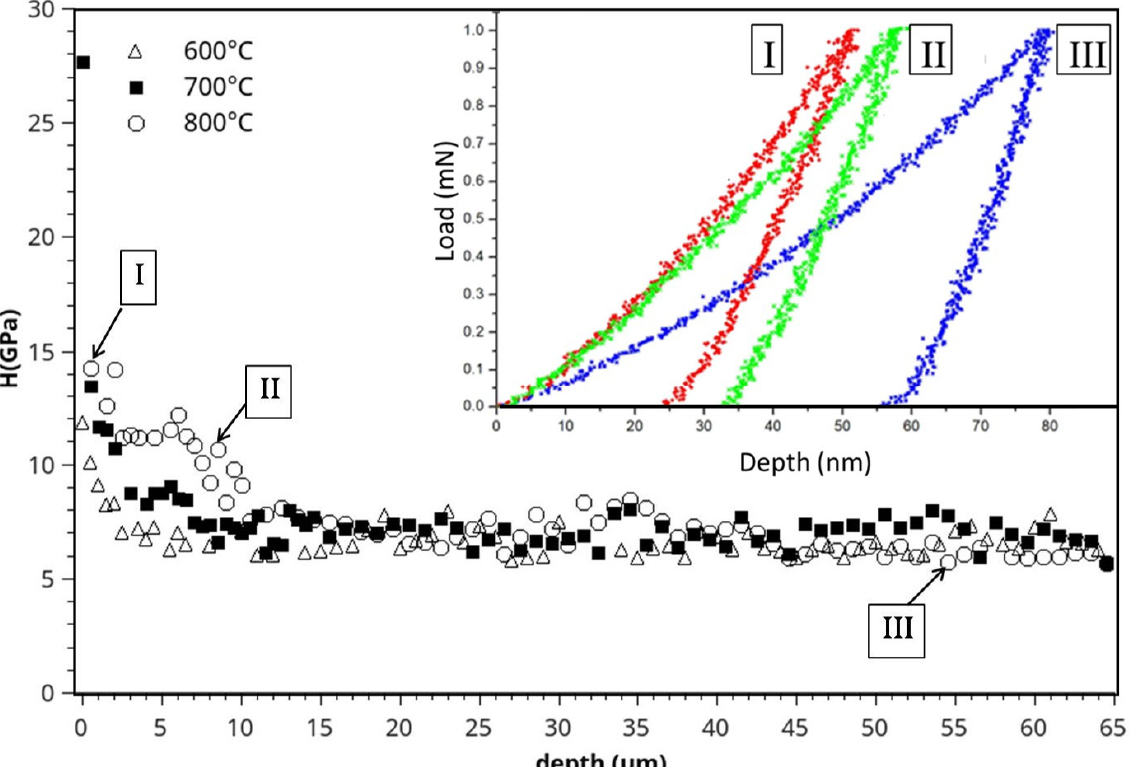
Figure 4. Hardness profiles for 3 treatments at 600 °C, 700 °C and 800 °C. Inset loading-unloading curves obtained for sample treated at 800 °C in three zones (I, II, III) defined on the profile.